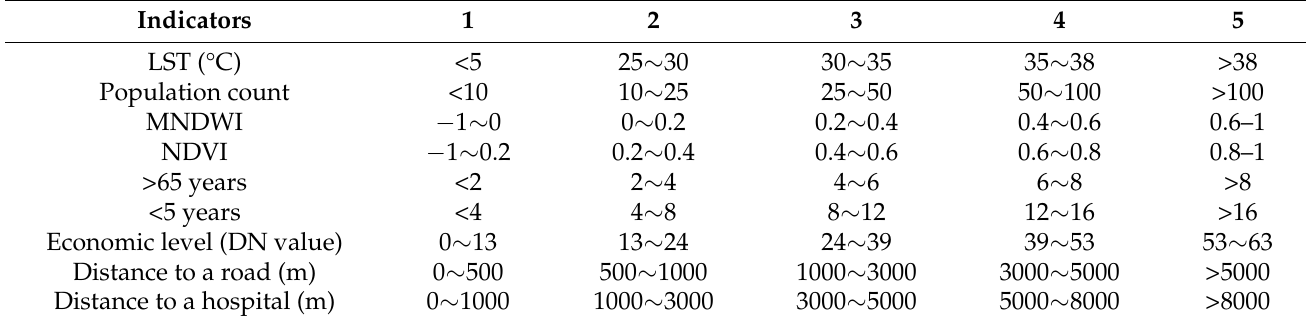
Table A1. Grading standards for each indicator.